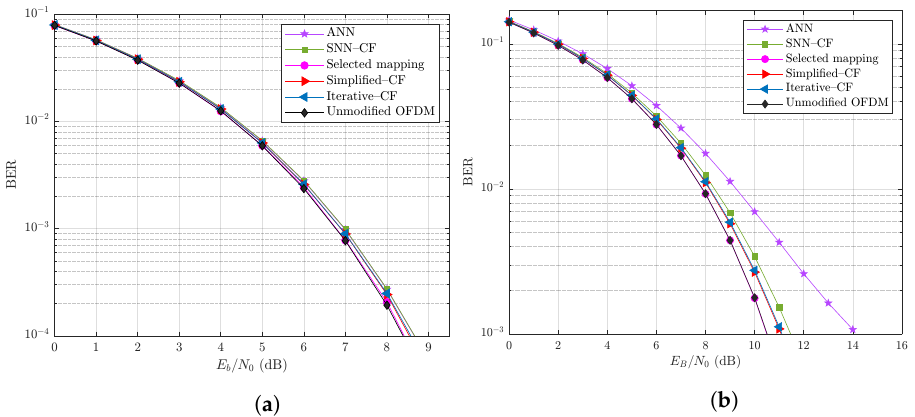
Figure 8. BER performance of the proposed SNN-CF vs. ANN [12], selected mapping [4], simplified- CF [8], iterative-CF [5], and unmodified OFDM for ( a ) QPSK-OFDM; and ( b )